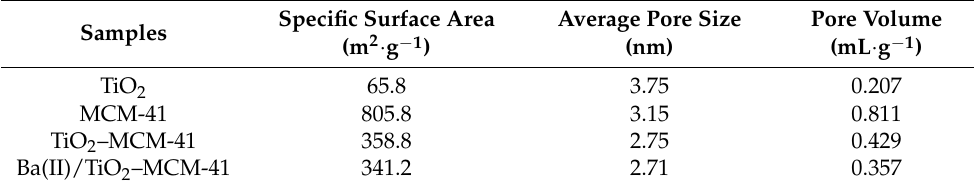
Figure 1. Pore size distribution of Ba(II)/TiO 2 –MCM-41 and TiO 2 –MCM-41. Table 1. S BET and pore parameters of different materials.